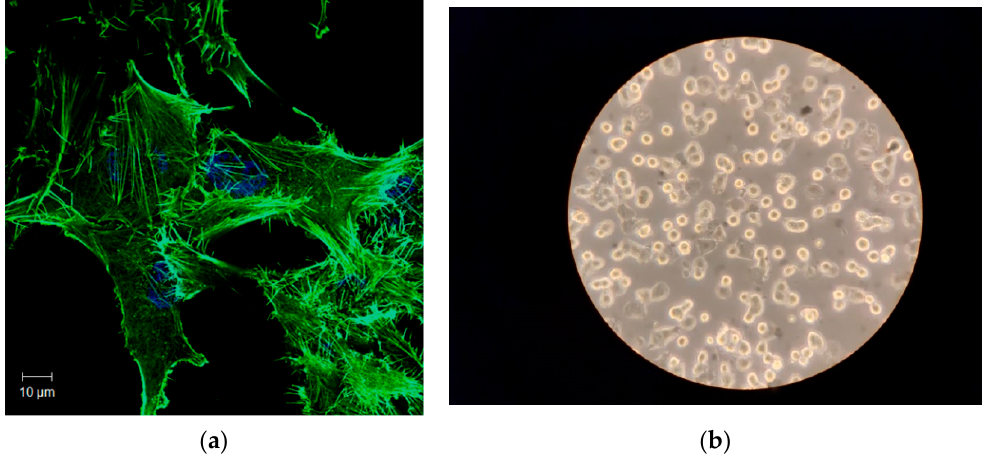
Figure 8. Representative images of the studied human osteoblasts. ( a ) Confocal micrograph. Actin cytoskeleton was labeled with rhodamine-phalloidin (green) and cells nuclei were stained with DAPI (blue); ( b ) Microscopic image of the studied human osteoblasts deposited in the substrate.